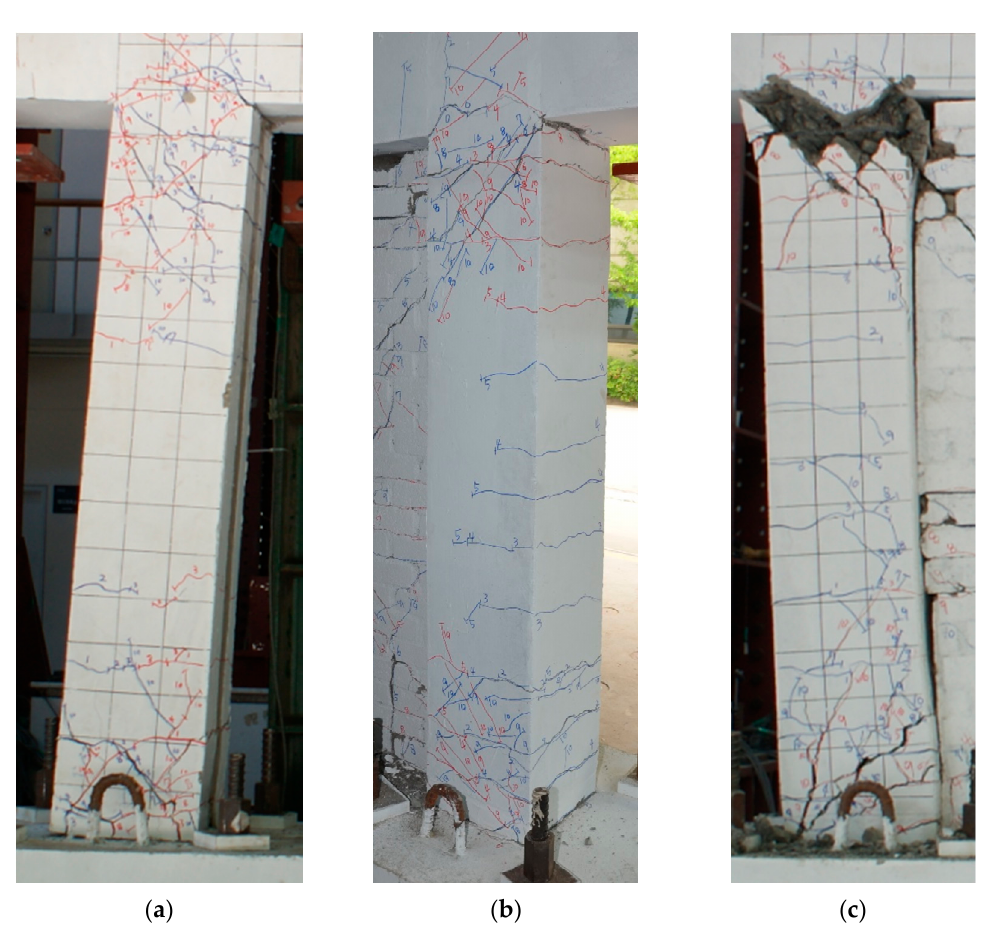
Figure 8. Failure of columns. ( a ) BF, ( b ) IF-0.5, ( c )